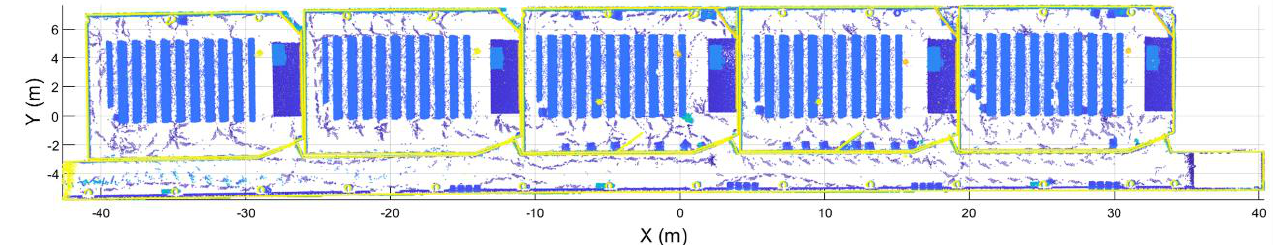
Figure 19. Case of study.